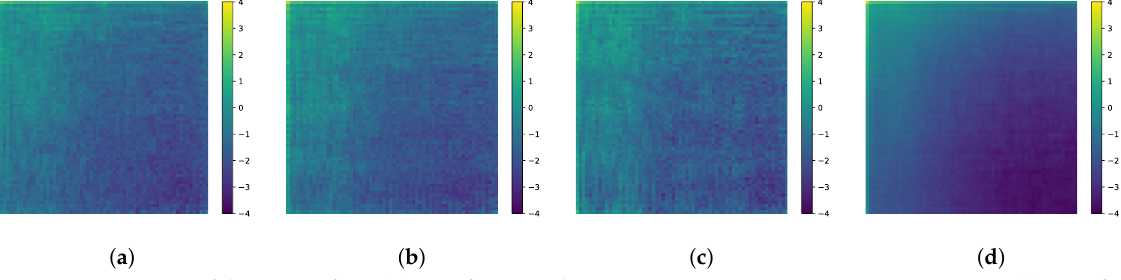
Figure 17. Mean spectra of the images from ( a ) TransfGAN with λ G = 0.0001, λ D = 0.0001, no extra training, ( b ) TransfGAN with λ G = 0.00005, λ D = 0.00005, no extra training, ( c ) TransfGAN with λ G = 0.0005, λ D = 0.0005, with extra training, ( d ) the real sidescan